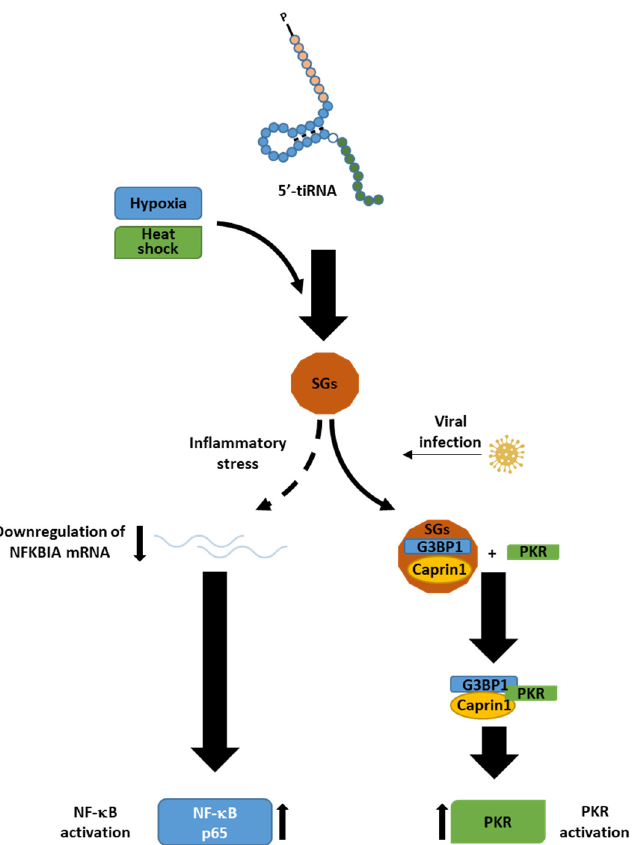
Figure 6. Stress granule formation is mediated by tiRNAs. 5’-tiRNAs promote the formation of stress granules (SGs), phase-separated cytoplasmic ribonucleoproteins assemblies lacking in membranes that condense mRNAs, ribosomal components, RNA binding proteins, and translation initiation factors [114], in response to stress conditions such as hypoxia and heat shock. Through the activation of NF- κ B and PKR, SGs play a role in immunity. SGs reduce the production of NFKBIA mRNA, which would normally block the NF- κ B pathway during the inflammatory process. As a result, SGs boost the NF- κ B pathway. Virus infection also increases the association of G3BP1, Caprin1, and PKR, resulting in the G3BP1-Caprin1-PKR complex. SGs play a role in PKR activation through the